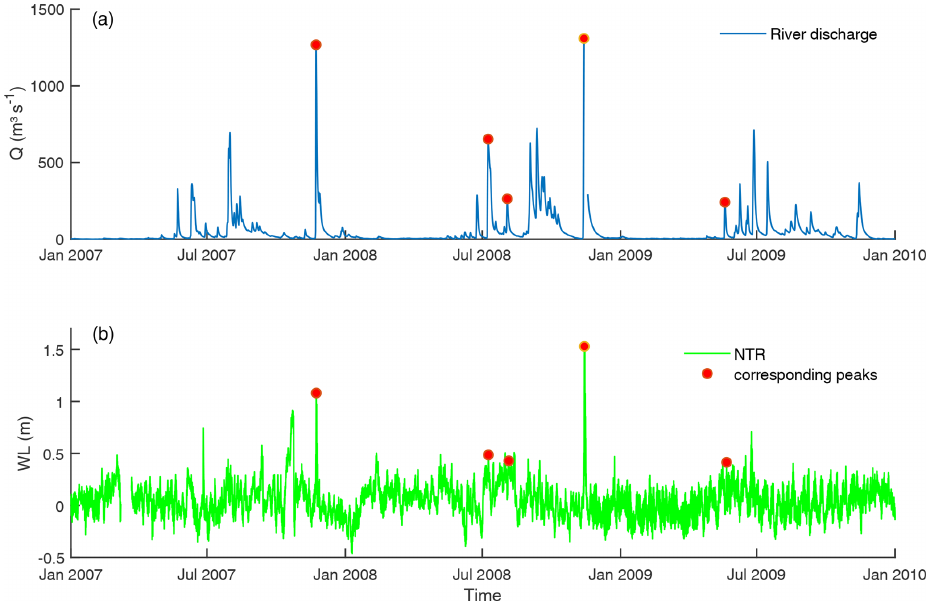
Figure D2. River discharge for the period 2007–2010 with peaks (red markers) occurring within 3d before peaks of NTR (a) . NTR at Witsand with peaks (red markers) occurring within 3d after peaks of river discharge (b) . The period 2007–2010 was chosen for representative reasons, as this was the period containing the most